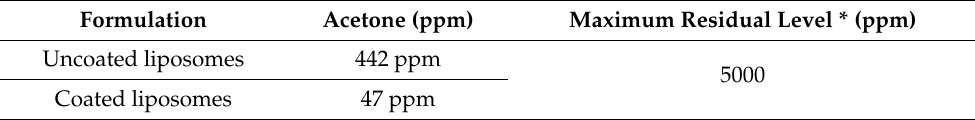
Table 4. Concentration of residual organic solvent in the optimized